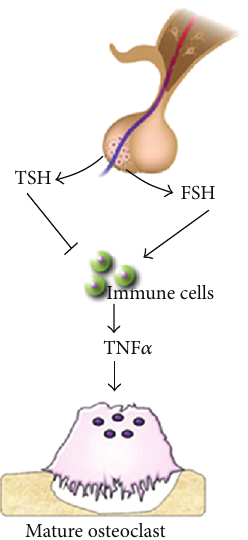
Figure 1: Scheme of pituitary-bone axis. FSH and TSH effects on bone turnover via TNF 𝛼 secretion by cells of immune